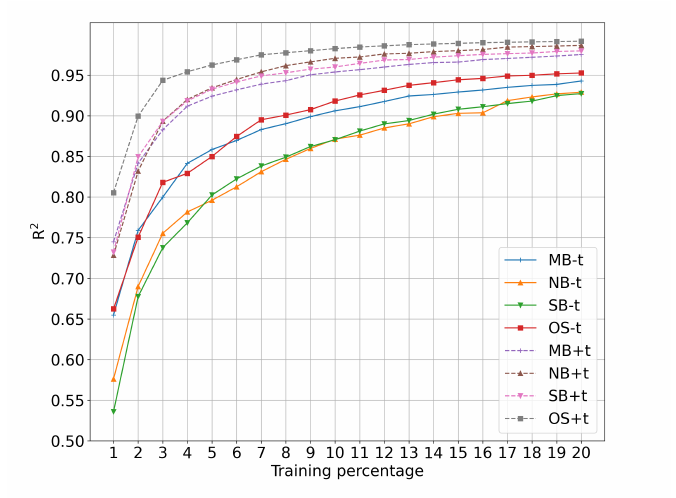
Figure 6. Nearshore station-based R 2 scores as a function of percentage of available data used to train the model. “+t” series denote the time used as an input in the